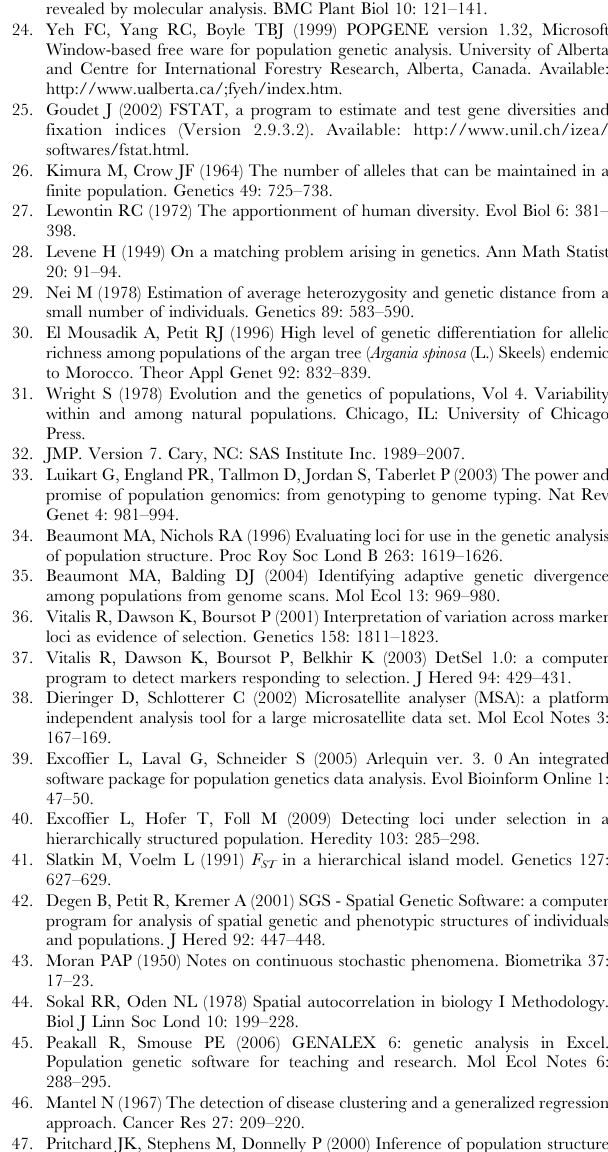
Table S3 Shared alleles between SL (SL90, SL99), Var2, Var6 (Var6*) and VAR (VAR*).